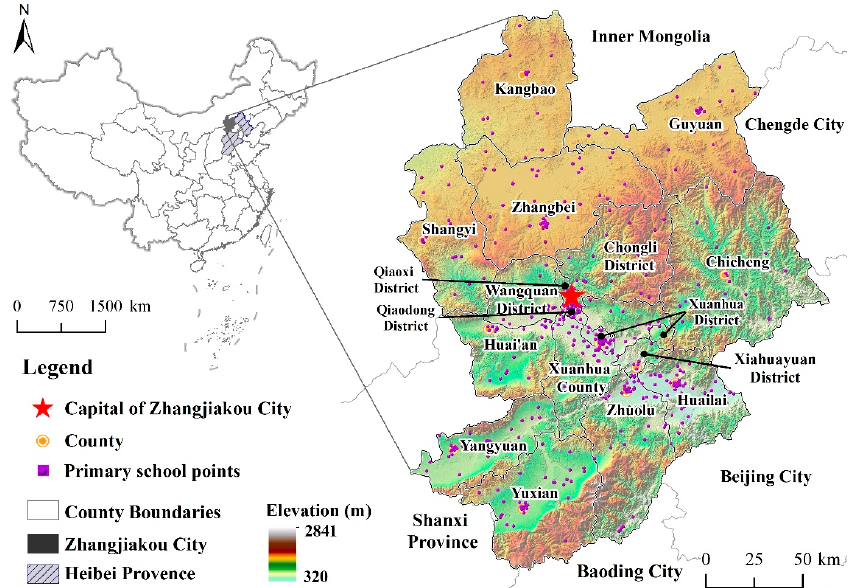
Figure 1. Map of the study area. Administrative divisions of China are based on a standard GS map (2016) 2884, downloaded from the standard map service website of the National Administration of Surveying, Mapping, and Geographic Information Technology.